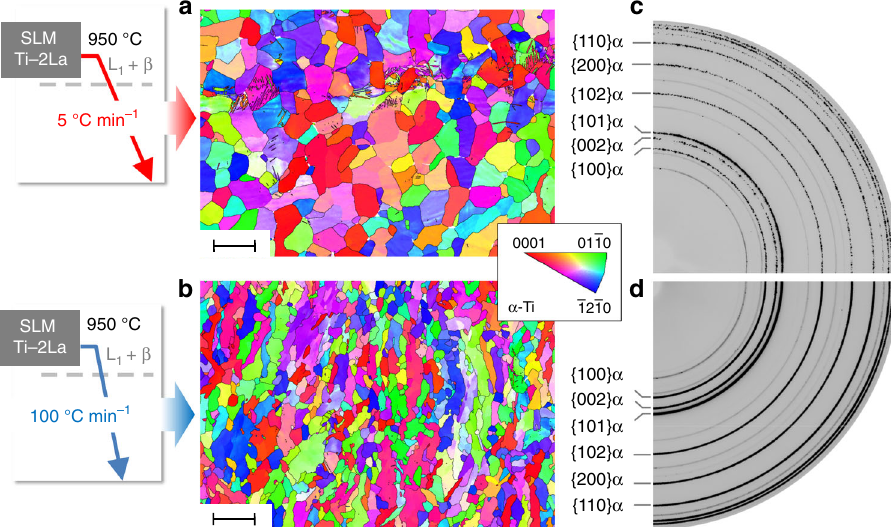
Fig. 3 Grain re fi nement in the Ti-2wt.% La (Ti-2La) alloy after selective laser melting (SLM). Post thermal treatment of the SLM as-built condition by cooling with a 5 °C min − 1 and b 100 °C min − 1 from 950 °C (L 1 + β fi eld) down to room temperature, results in the formation of new α grains of smaller size with increasing cooling rate and extensive globularization. Scale bars, 50 μ m. c , d Representative quarters of Debye – Scherrer rings obtained for a gauge volume of 1 × 1 × 5 mm 3 and the microstructures shown in a , b respectively. The spotty rings obtained for 5 °C min − 1 compared with the continuous {hkl} α rings shown for 100 °C min − 1 , re fl ects for the latter a remarkably smaller grain size in the bulk of the alloy. Black lines in a , b indicate high angle grain boundaries (misorientation